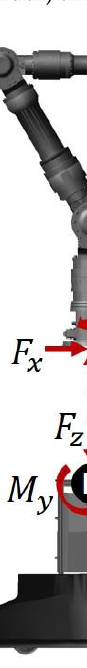
Figure 3. Connection point P of the mobile platform with the manipulator.